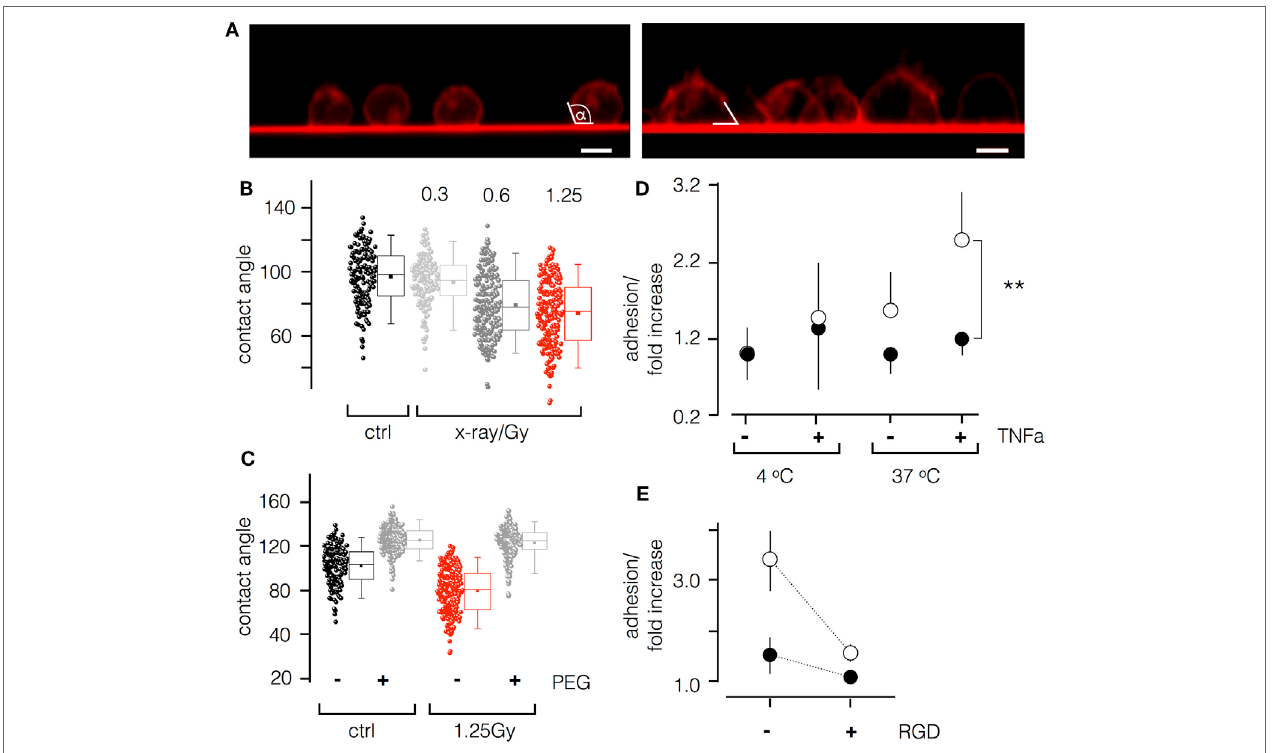
FigUre 4 | Ionizing irradiation stimulates adhesion of Jurkat cells and peripheral blood lymphocytes (PBL). (a) Side view of Jurkat cells with fluorescent plasma membranes on glass surface. Confocal images of non-irradiated cells (left panel) and of cells 48 h after irradiation (1.25 Gy, right panel) were taken 10–15 min after incubating cells on red fluorescent glass cover slip. White lines indicate the contact angle between cell and glass surface. (B) Box plot of contact angles for un-irradiated cells and cells irradiated with increasing doses of X-ray. (c) Contact angles of un-irradiated (ctrl) and irradiated cells (1.25 Gy) on untreated ( − ) or polyethylene glycol (PEG) pretreated ( + ) cover slips. Data obtained as in (B) . Box plot symbols have the same meaning as in Figure 2 . (D) Relative adhesion rates of Jurkat cells and PBL to endothelial cells (ECs). Non-irradiated (closed circles) or irradiated (1.25 Gy X-ray) Jurkat cells at 4 or 37°C with or without stimulation of ECs with TNF- α (20 ng/ml). Mean value ± SD ( N = 4; n = 12). (e) Cells as in last column of (D) with or without 10 µM RGD peptide in incubation